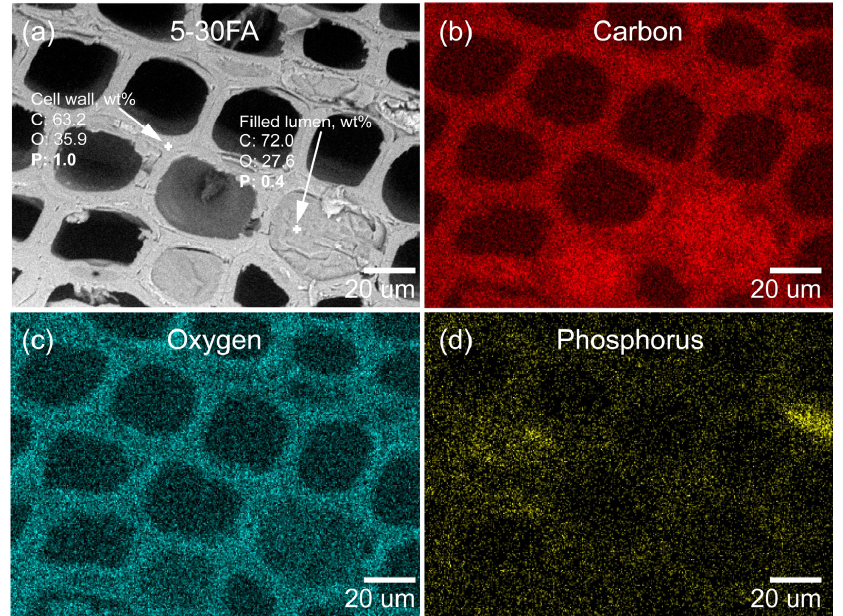
Figure 5. Low-vacuum SEM image and EDX spot analysis of ( a ) cross-sectioned earlywood sample (5-30FA), with corresponding EDX mapping of ( b ) carbon, ( c ) oxygen, and ( d ) phosphorus.